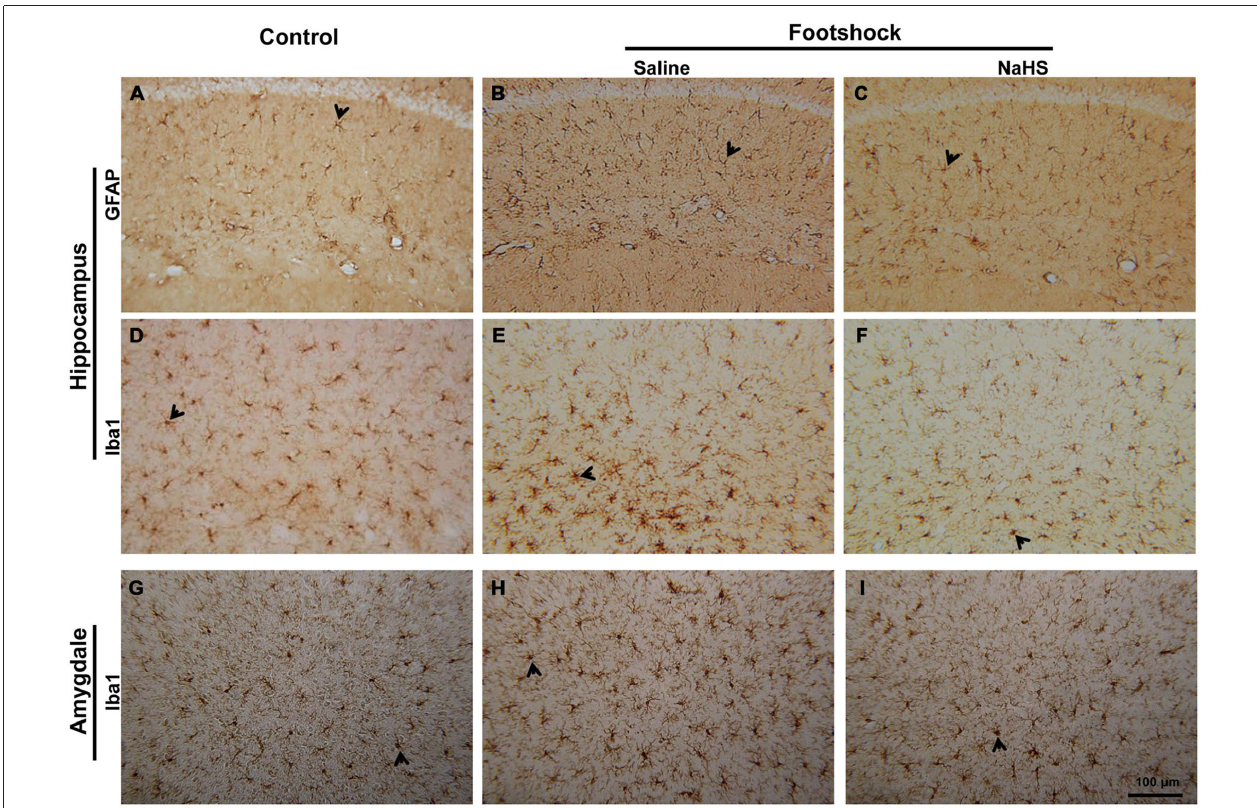
FIGURE 10 | NaHS reduced neuroinflammation in mice with footshock . (A–C) Representative immunostaining of activated astrocytes (GFAP) in the CA1 subregion of the mouse hippocampus. (D–F) Representative immunostaining of activated microglia (Iba1) in the CA1 subregion of the mouse hippocampus. (G-I) Representative immunostaining of activated microglia (Iba1) in the basolateral nucleus of the mouse amygdala (BLA). Scale bar = 100 µ m. Arrowheads indicated positive staining for GFAP and Iba1 ( n = 3–5 per group).